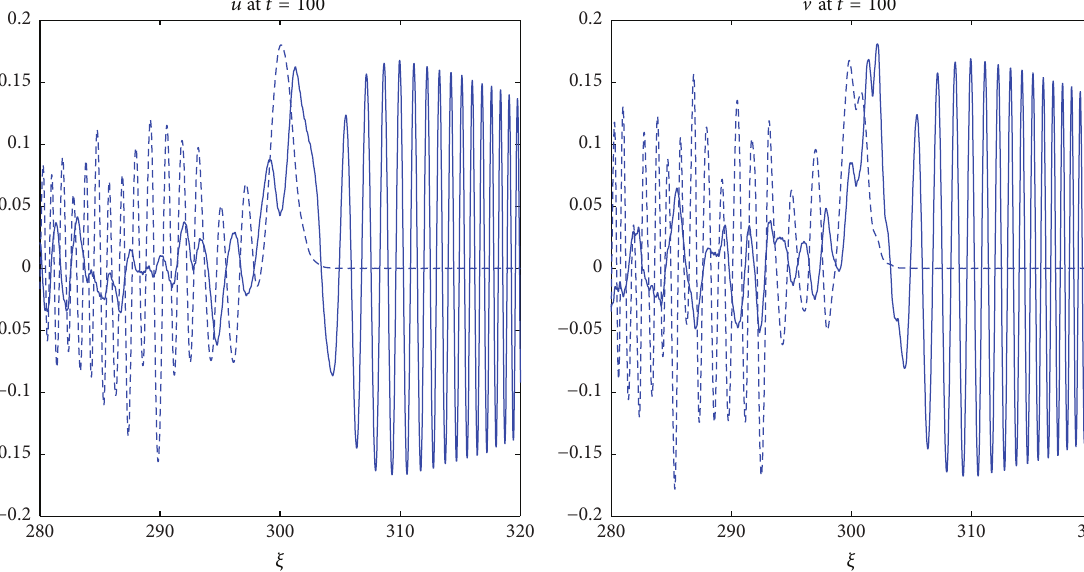
Figure 16: Propagation of a Gaussian pulse over a channel with variable depth. Observe the effect of surface tension on the dynamics of the pulse. Parameters: 𝛼 = 0 , 𝛽 = 0.01 . Solid line: 𝜎 = 0.6 . Dashed line: 𝜎 = 0